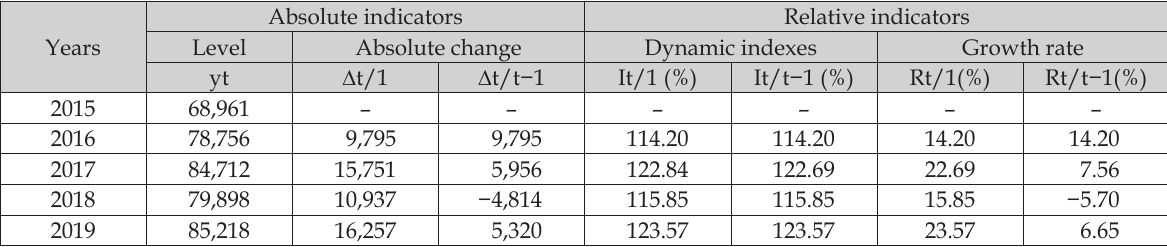
Table 3. Evolution of the chronological indicators of the number of tourists in the Danube Gorge.